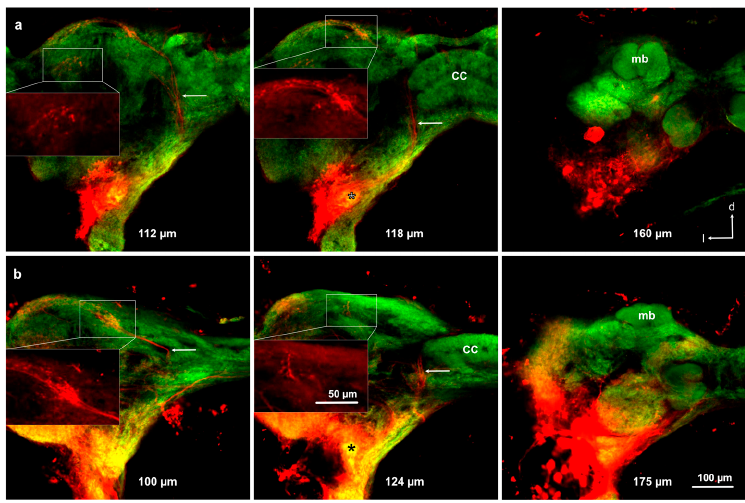
Figure 6. Projection neurons originating from the antennal lobe in Libellula depressa nymphs (F3 instar) in two individuals ( a , b ). Individual sections from anterior (left) to posterior (right). Distance from anterior side of the brain is provided in micrometers. Asterisks indicate dye injection site into the antennal lobe. Arrows indicate medial antennal lobe tract. Insets show z-projections over 10 µ m of the Microruby-stained axons (the same scale bar applies for all insets). cc central complex, d dorsal, l lateral, mb frontal part of mushroom bodies. Note that central neurons project through the medial antennal lobe tract to the lateral protocerebrum, but not to the mushroom bodies. Microruby stained axons in red and background staining with the anti-synapsin antibody in